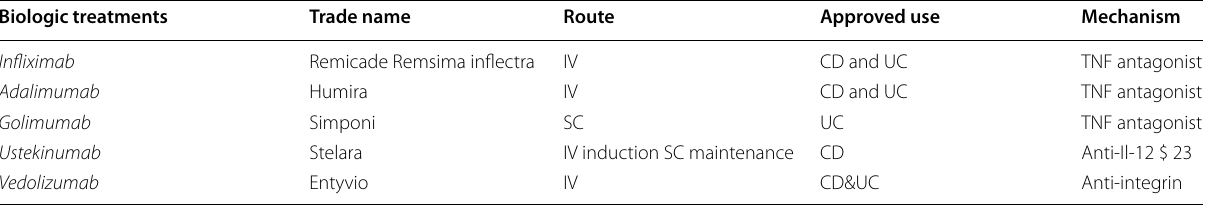
Table 1 Approved monoclonal antibodies IFX, ADA, UST, VDZ and golimumab in IBD therapy; IL, interleukin; IV, intravenous; SC, subcutaneous